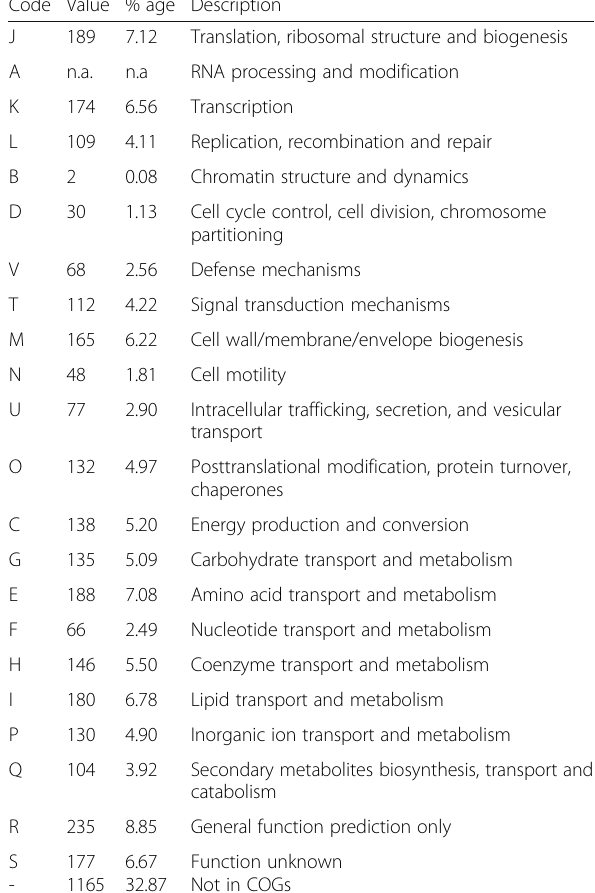
Abbreviation: n.a. not assigned The total is based on the total number of protein coding genes in the